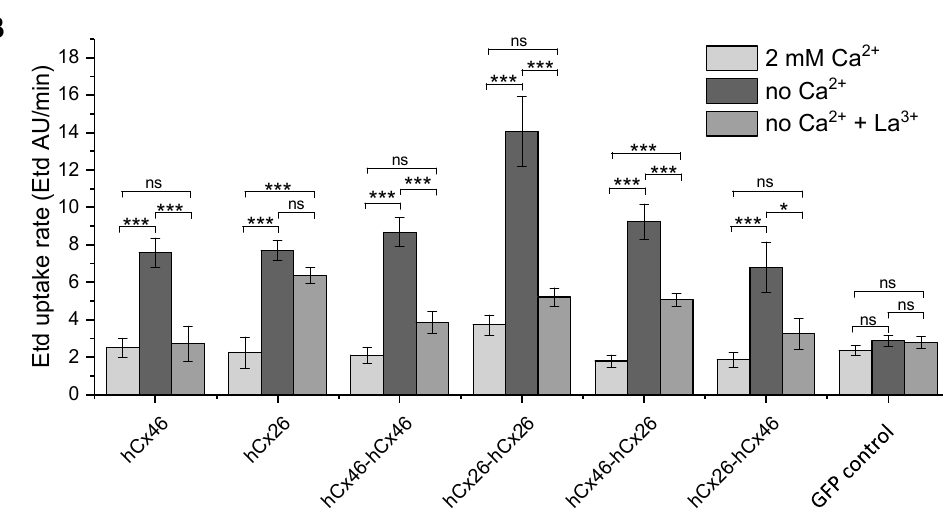
Figure 5. Dye uptake through hemichannels using ethidium bromide. HeLa cells were grown on coverslips to a confluency of about 40–50% and transfected with IRES-GFP-plasmids. The GFP allowed the identification of transfected cells by fluorescent microscopy. ( A ) Time course of dye uptake experiments by cells expressing the different variants when perfused with bath solutions containing 2 mM Ca 2+ , no Ca 2+ , and no Ca 2+ but 1 mM La 3+ . The fine lines show the SEM spread for all measured points. The symbols indicate the average for data points measured every 1 min. The solid lines indicate the part of the curves that was used to estimate the dye uptake rate. ( B ) Quantification of the dye uptake rate (Etd AU/min) for all tested variants and the backbone control in absence or presence of Ca 2+ or La 3+ . The error bars represent the SEM. The data were evaluated by a one-way ANOVA and a post-hoc Tukey test (* p ≤ 0.05, *** p ≤ 0.001, ns: not